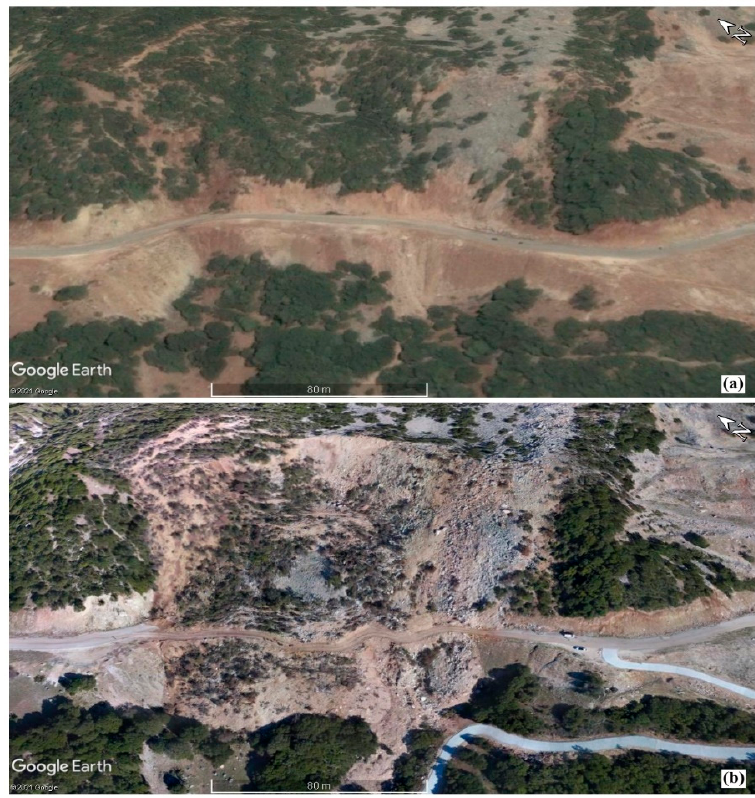
Figure 1. Landslide area. ( a ) Google Earth image covering the study area before the landslide. ( b ) Orthophoto of the study after the occurrence of the landslide.